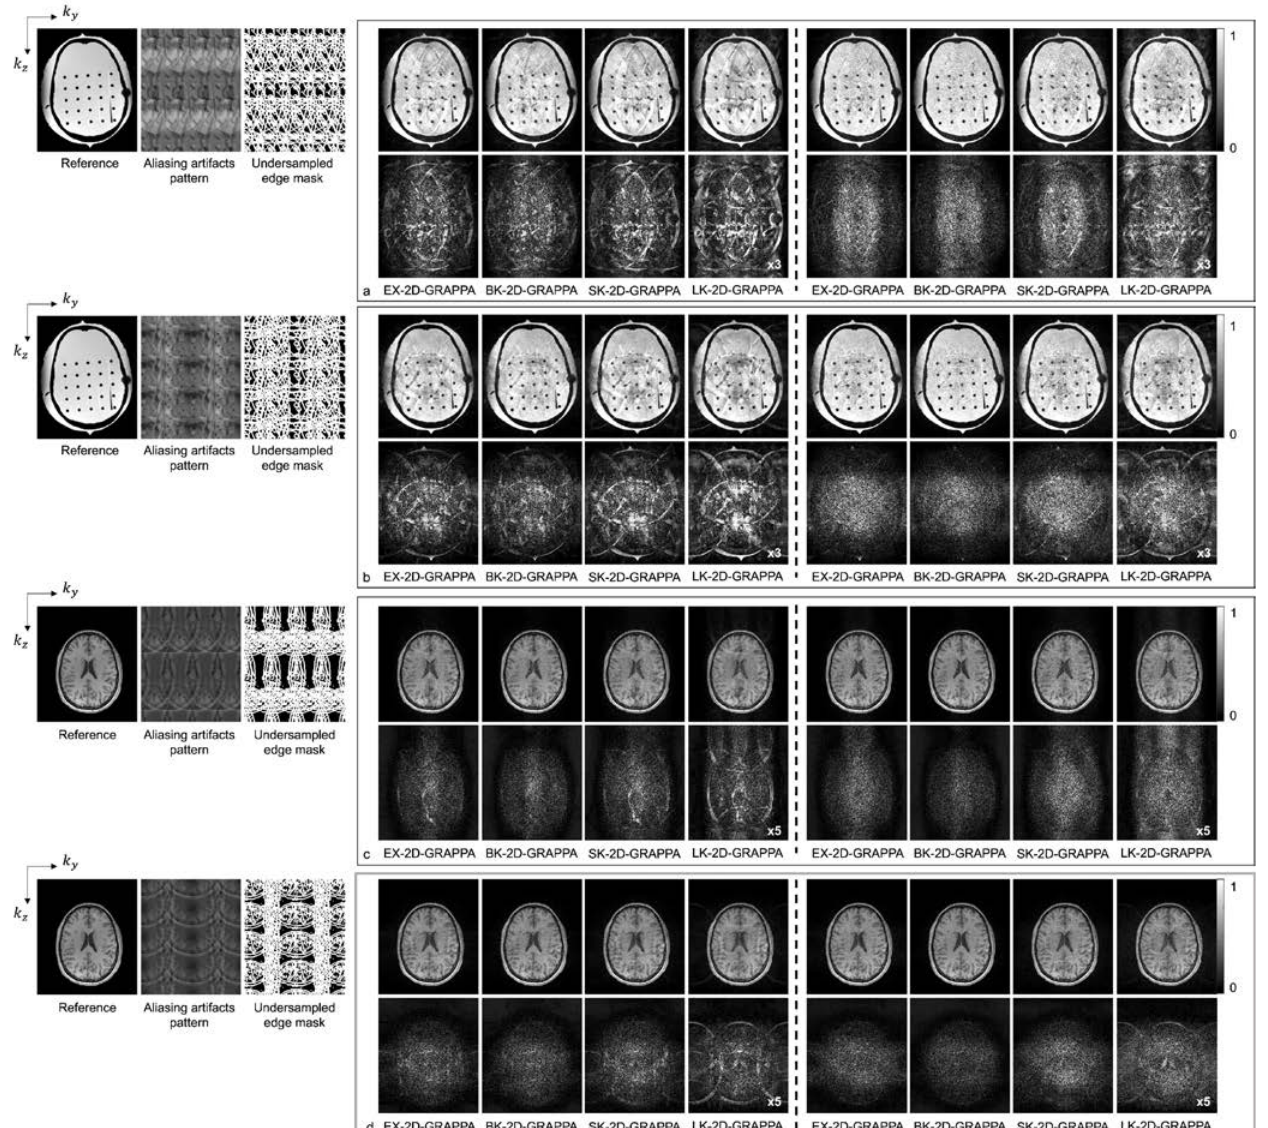
Figure 8. The reconstruction results of 2D-GRAPPA algorithms for ( a , b ) anthropomorphic head phantom and ( c , d ) in vivo data with AF = 8. The top rows in ( a , c ) were obtained when k z direction was more accelerated (2 × 4) and those in ( b , d ) were obtained when k y direction was more accelerated (4 × 2). Columns 1–4: basis kernel. Columns 5–8: expanded kernel.